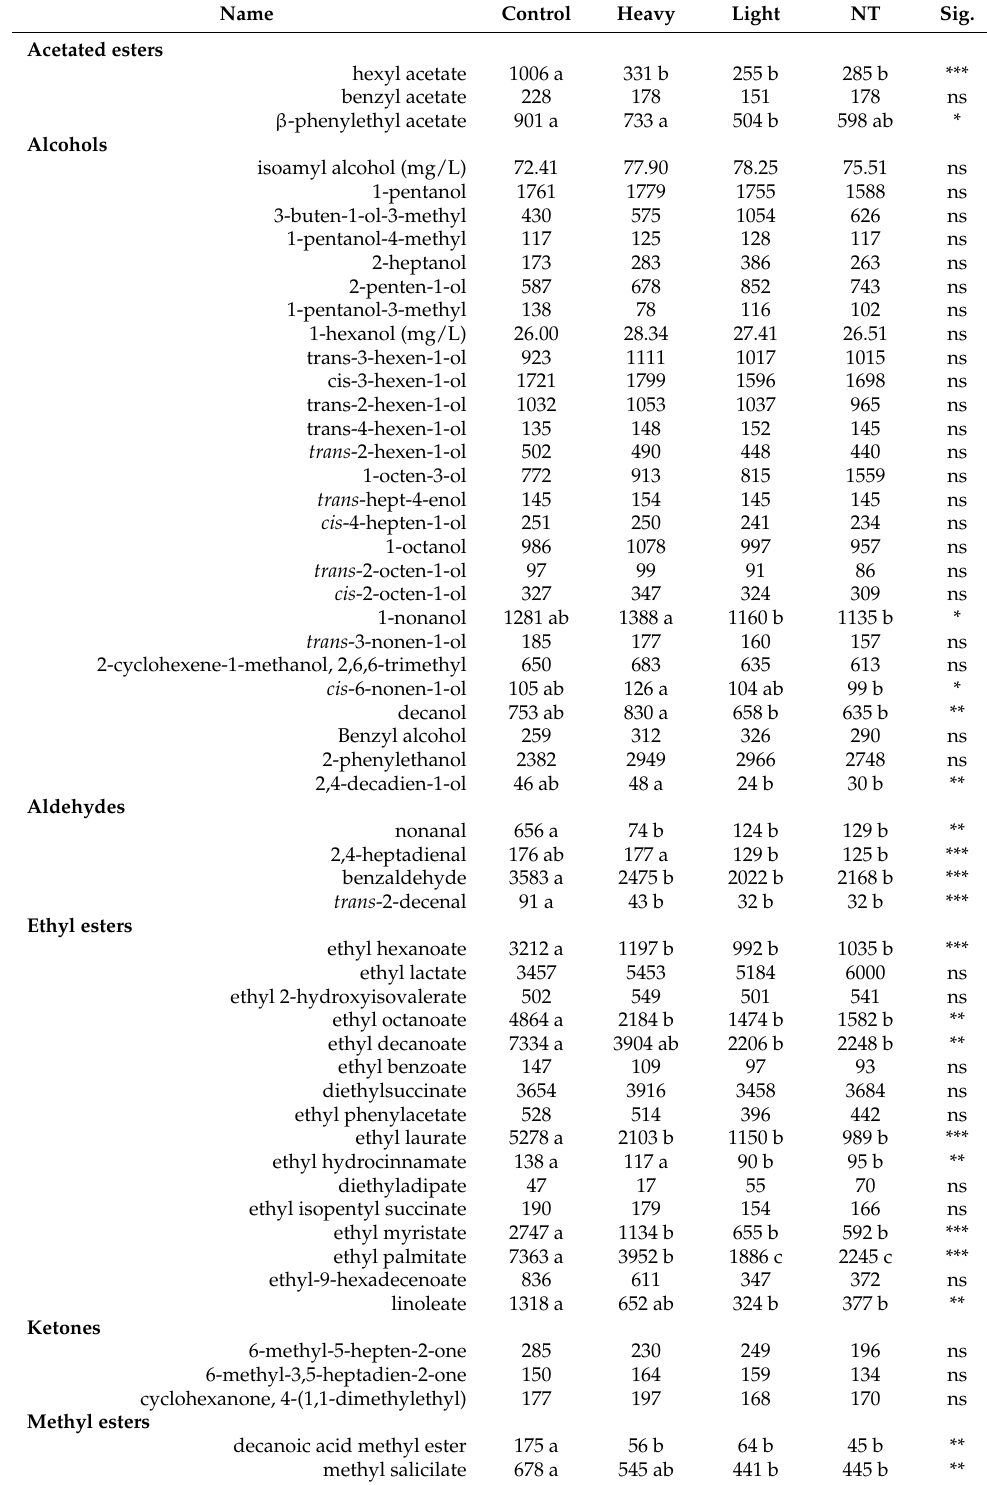
Table 4. Effect of toasting level on the general aromatic composition of the distillate. All data are expressed in µ g/L except where specifically indicated. Different letters within each row denote a significant difference between the wines at p < 0.05 (Tukey’s post hoc test). *, **, *** and ns: differences significant at p < 0.05, 0.01, 0.001 and not significant, respectively. The main groups of compounds analyzed are highlighted in